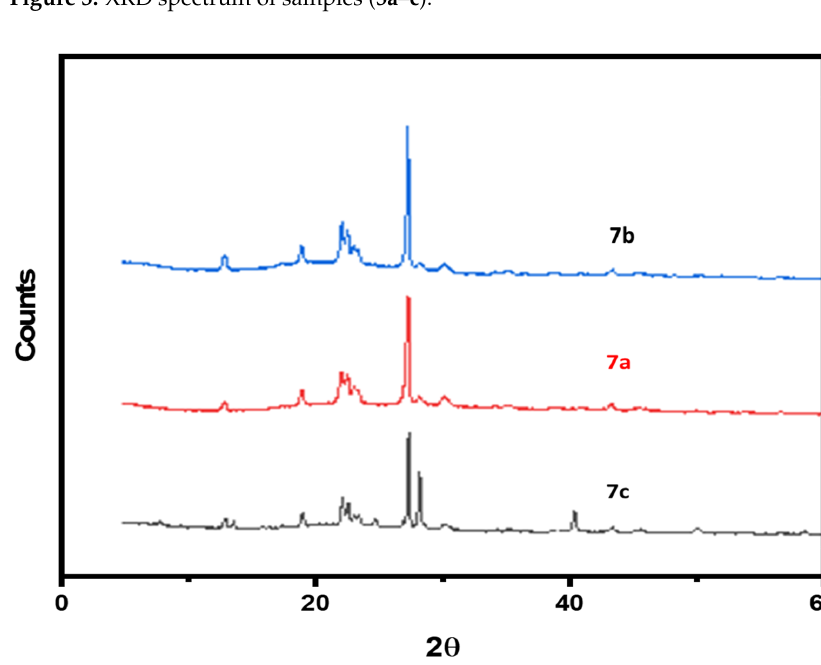
Figure 4. XRD spectrum of samples (7a-c).